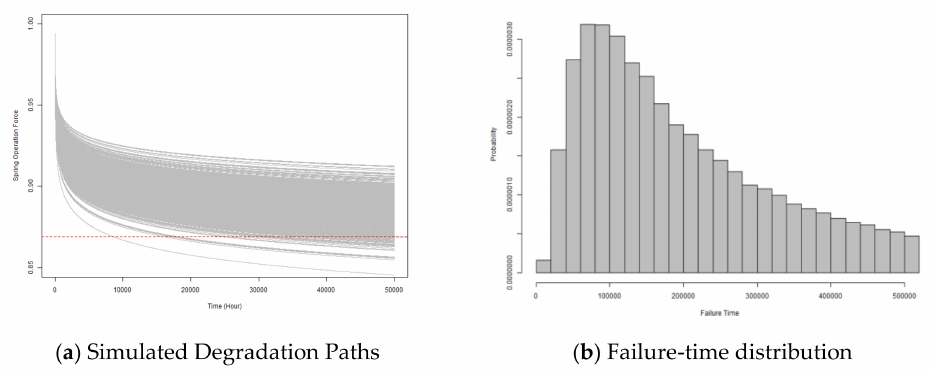
Figure 11. Simulated degradation paths and failure-time distribution at normal use conditions from the ADDT data.